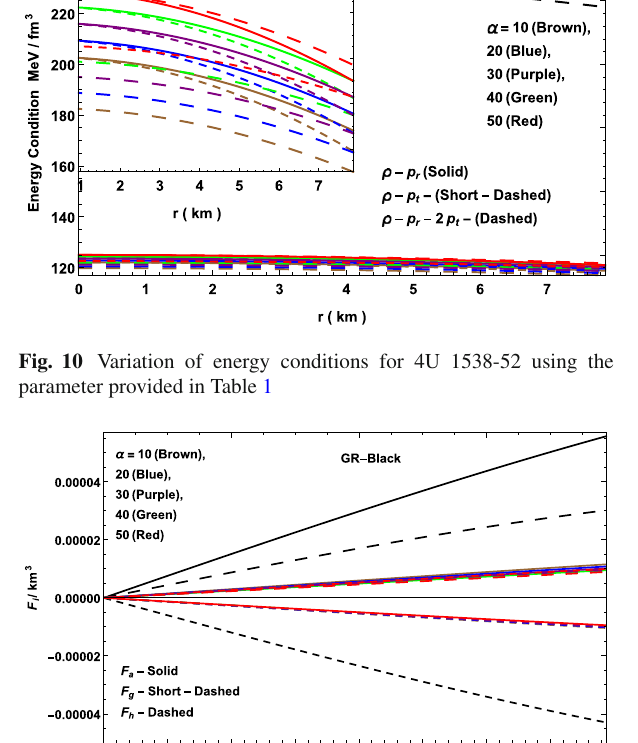
of 10 ≤ α ≤ 50, the resulting impact of the hydrodynamic